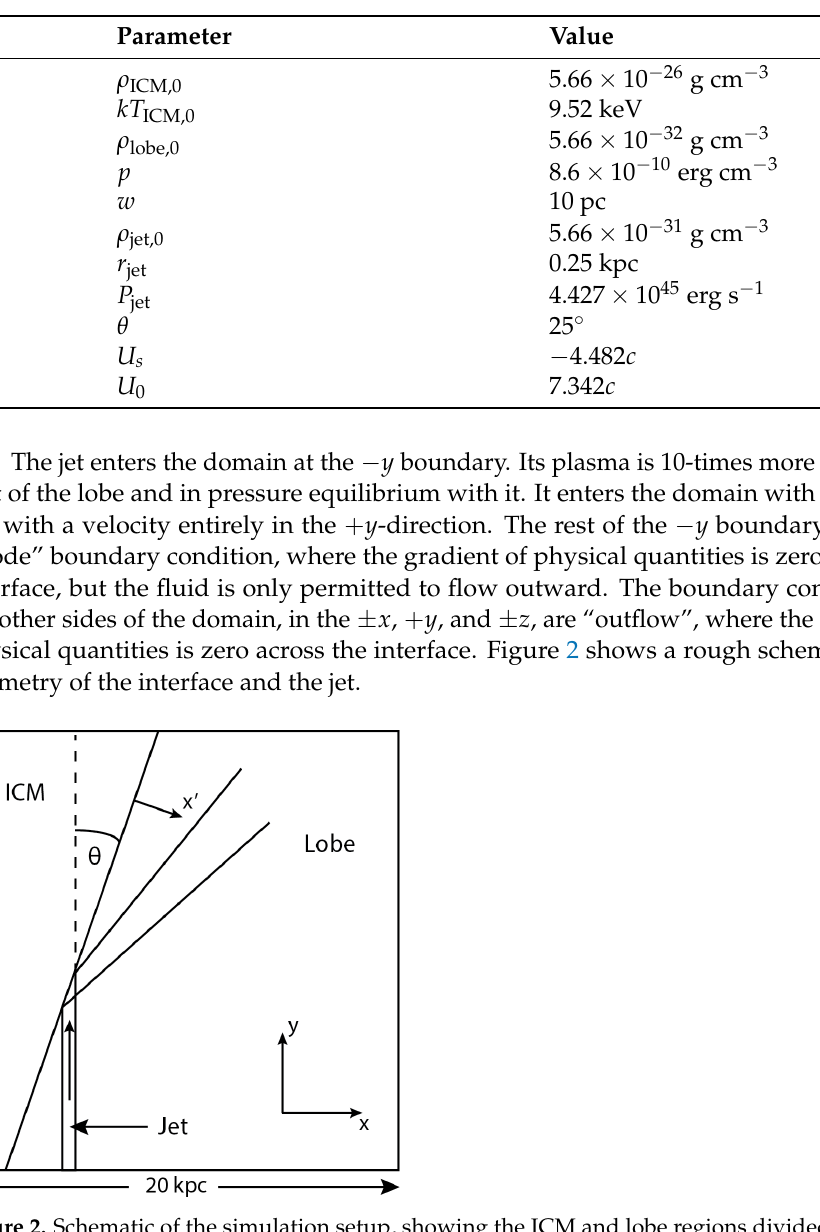
Table 1. Parameters for the “fiducial” simulation.